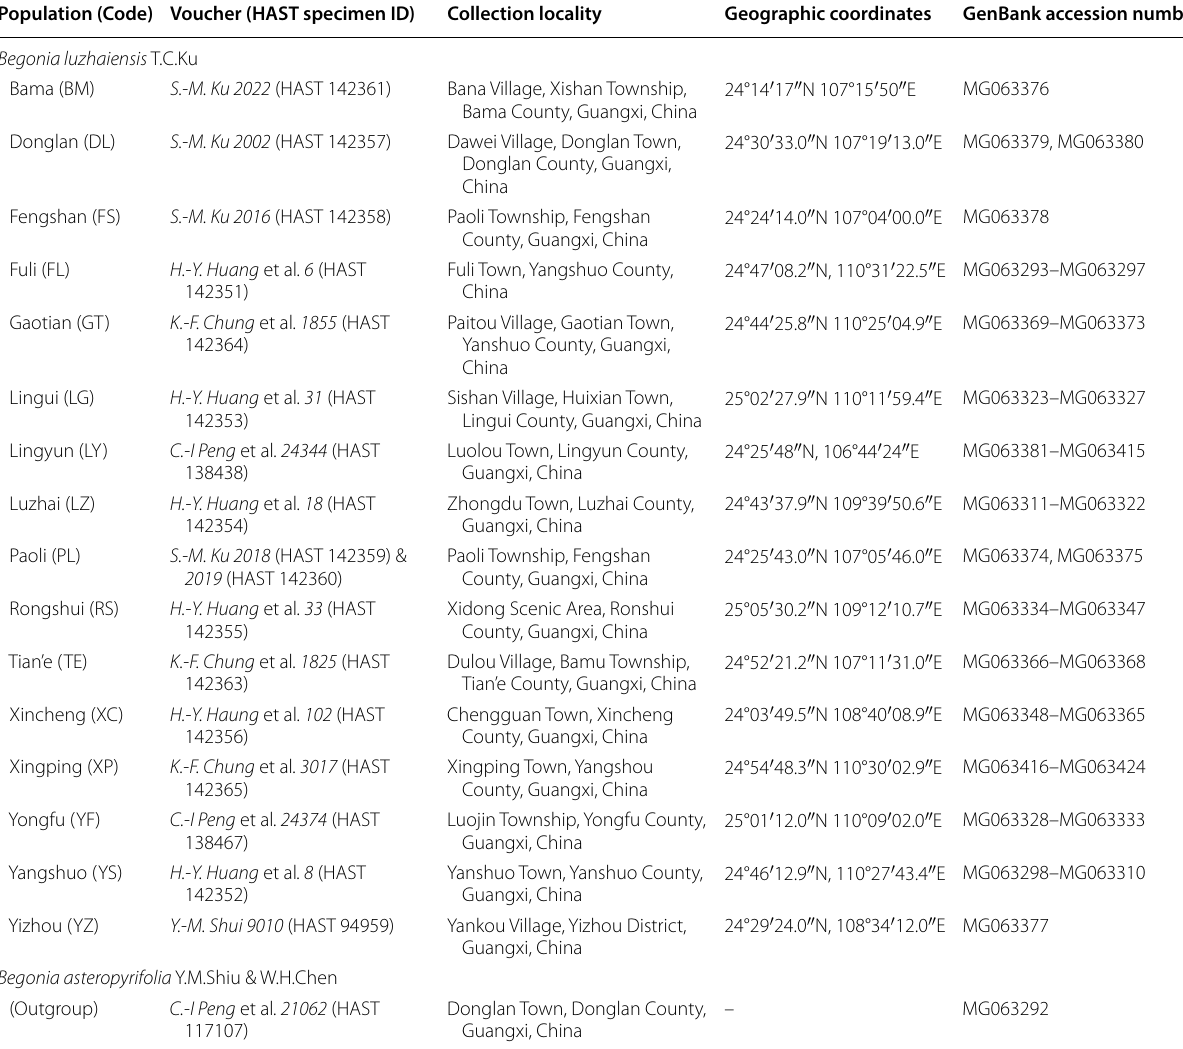
All voucher specimens are deposited in HAST. The HAST specimen ID is encrypted with the hyperlink to its digital image